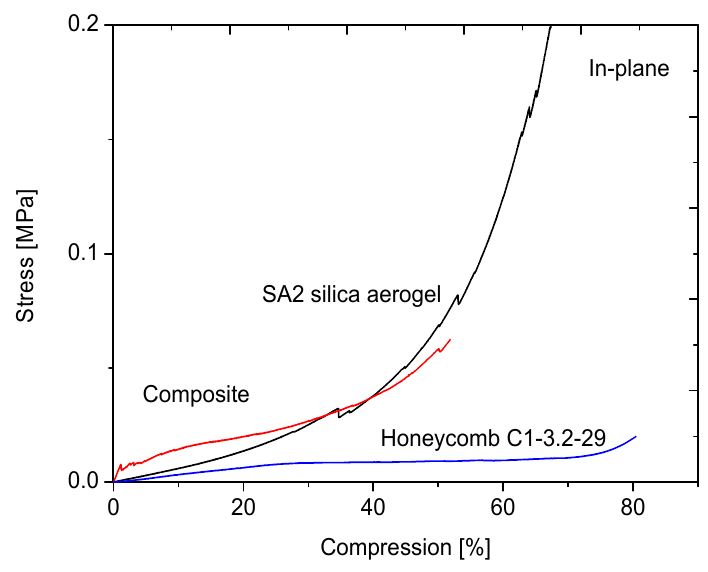
Figure 14. Compression curves of SA1 with C1-3.2-29 out-of-plane.